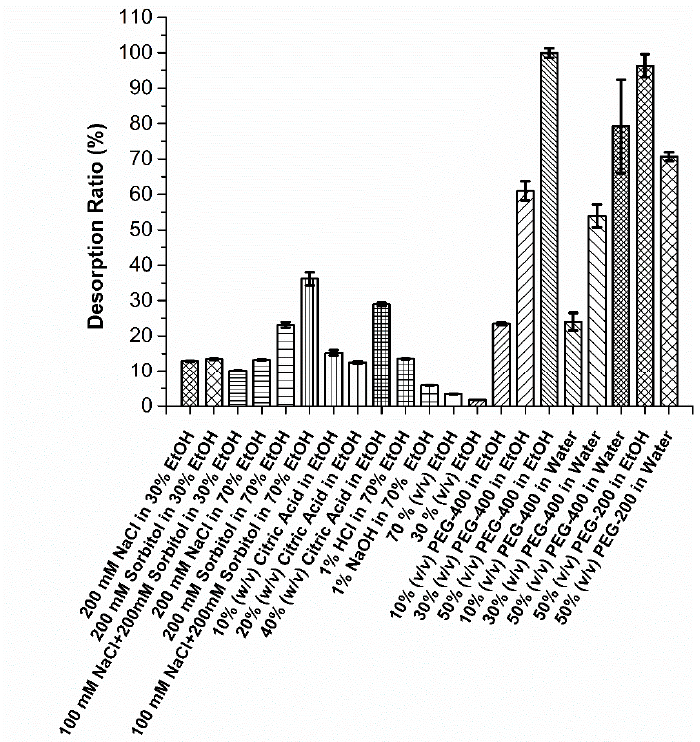
Figure 4. Desorption of total polyphenols from mPEG-5000 grafted silica particles using various solvents. Ethanol is abbreviated as EtOH. A 1 mL desorption solvent was used for recovery of grape pomace polyphenols adsorbed on 25 mg mPEG-5000-grafted silica particles. Error bars indicate a standard deviation observed for